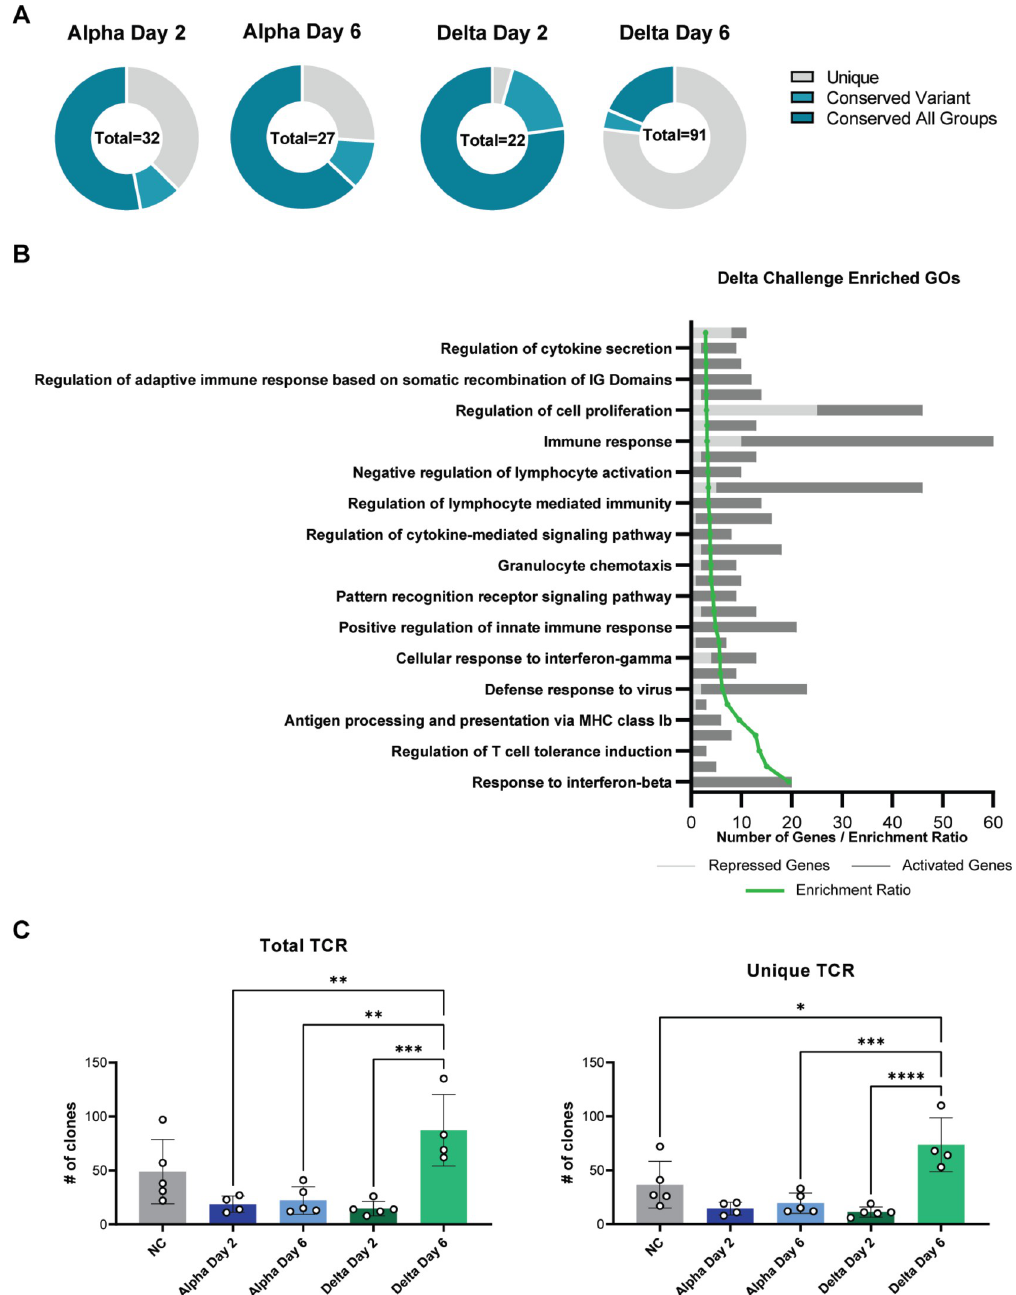
Fig 7. Gene ontology analysis of systems of genes in challenged mice. Circle plots indicate the number of unique or conserved sets of genes that were found to be enriched per each group (A). The top 30 enriched GO terms are shown and plotted per their relative level of expression and enrichment ratio (B). TCR clonotypes were mapped and represented as Total clones (C) or unique clones per unique CDR3 sequence (D). Total TCR clones (One-Way ANOVA P = 0.0005) and unique clones were increased between Delta day 2 and day 6 (One-Way ANOVA P < 0.0001). (n = 4 in Alpha Day 2 and Delta Day 6; n = 5 in Alpha Day 6 and Delta Day 2). 20 genes involved in general interferon responses. Total gene counts in lung RNA from each experimental group are shown in Fig 8A. Delta at day 6 shows high interferon dependent gene